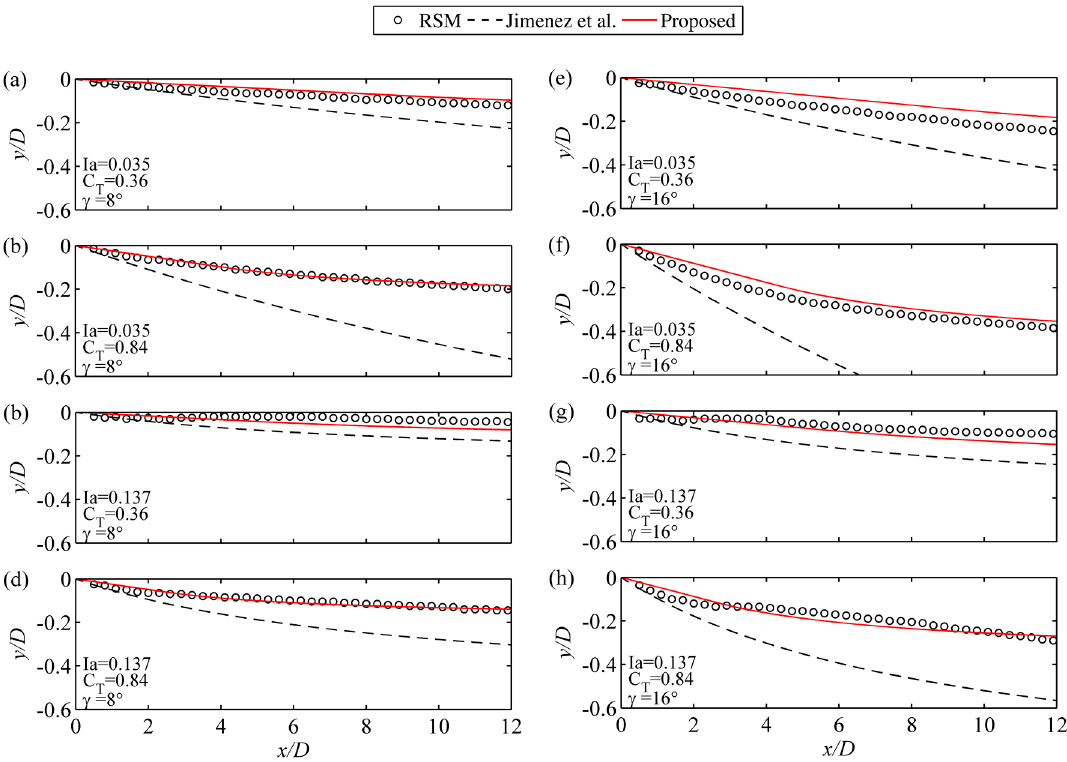
Figure 11. Validation for predicted wake deflections in yawed conditions.